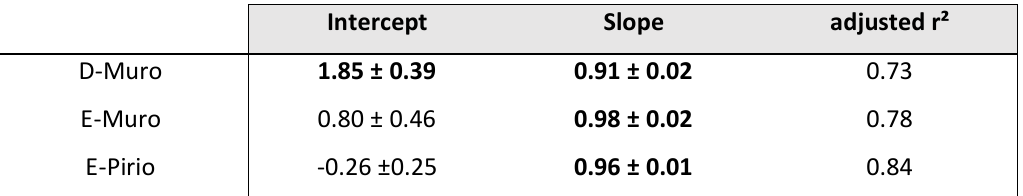
Table S1: Correlation between local average daily temperature (minimum daily temperature + maximum daily temperature / 2) from thermocron i-buttons placed in trees near nest boxes, in the three Corsican sites (E-Pirio, E-Muro and D-Muro) and from measures of the national meteorological station of Calvi from 2013 to 2016. Significant estimates (p-value < 0.05) are highlighted in bold.